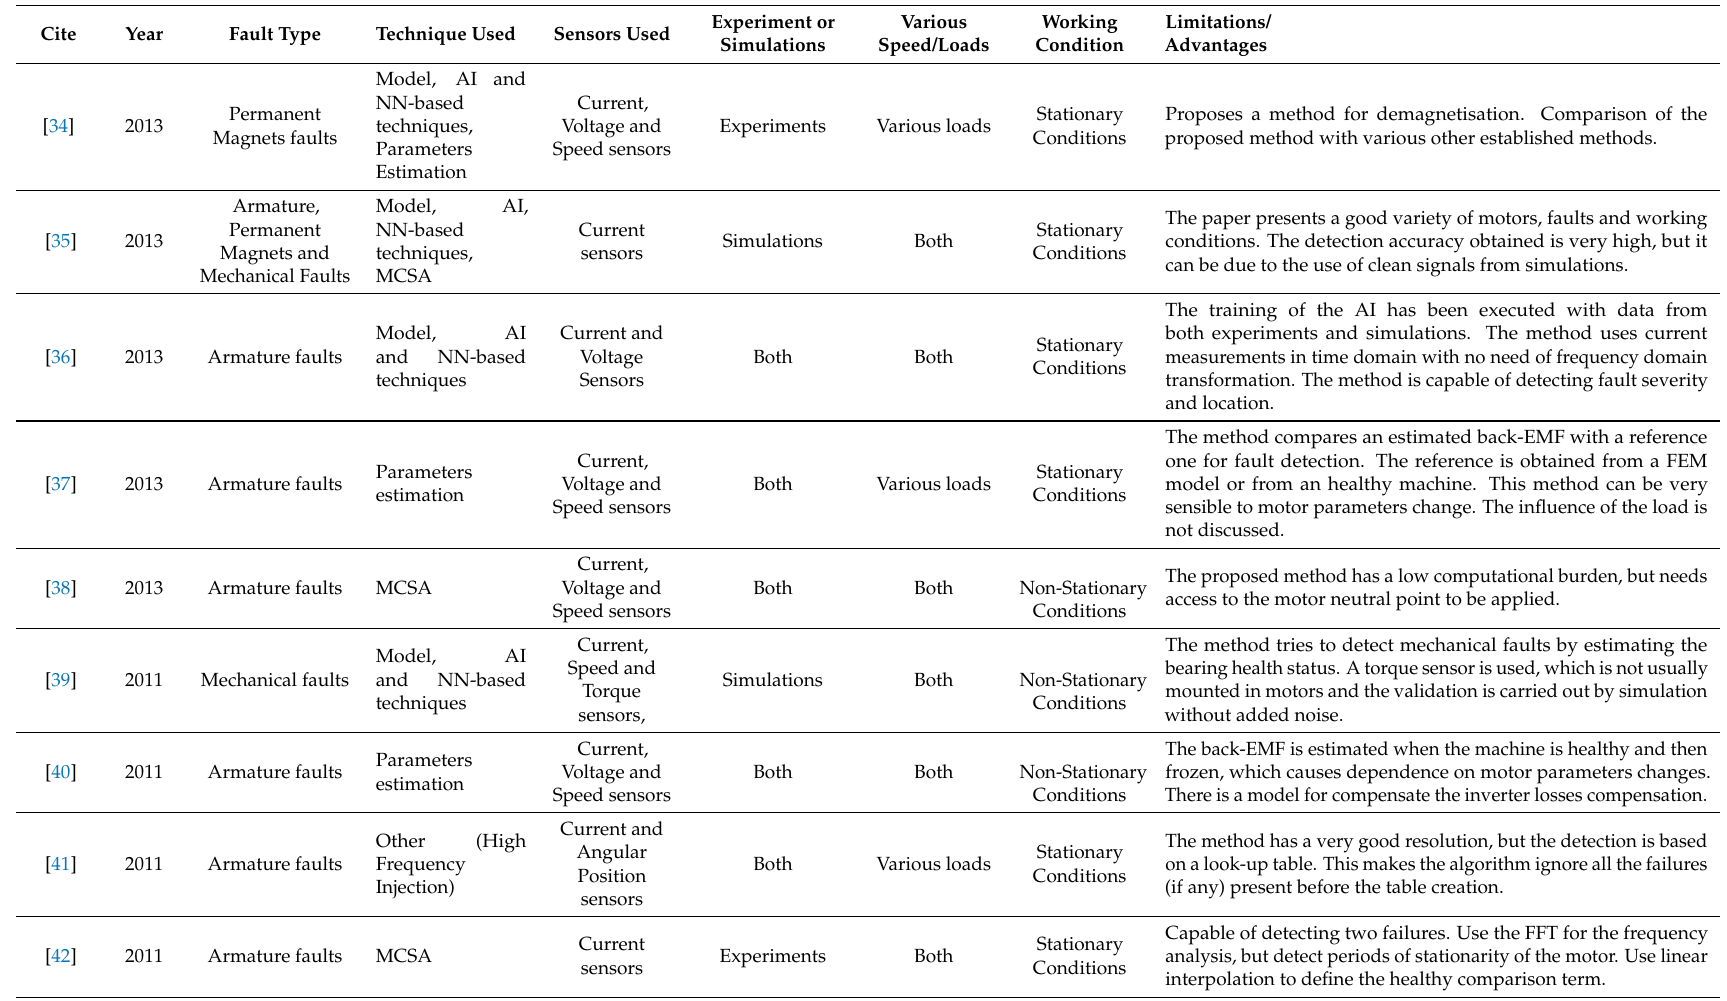
Table 4. Features table